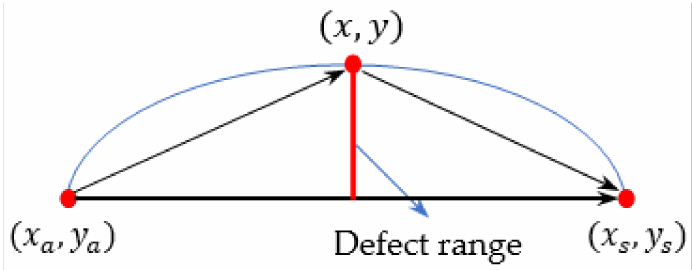
Figure 3. Schematic diagram of the calculation of β